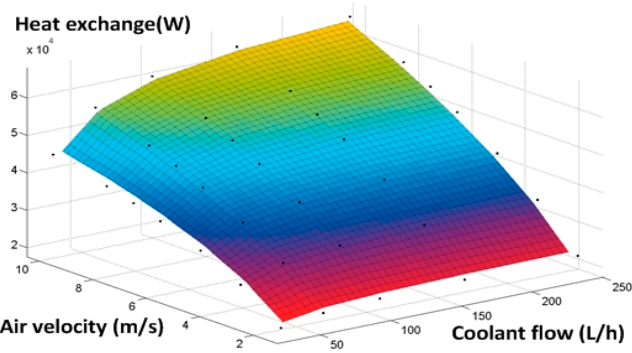
Figure 6. Radiator experimental data fitting.